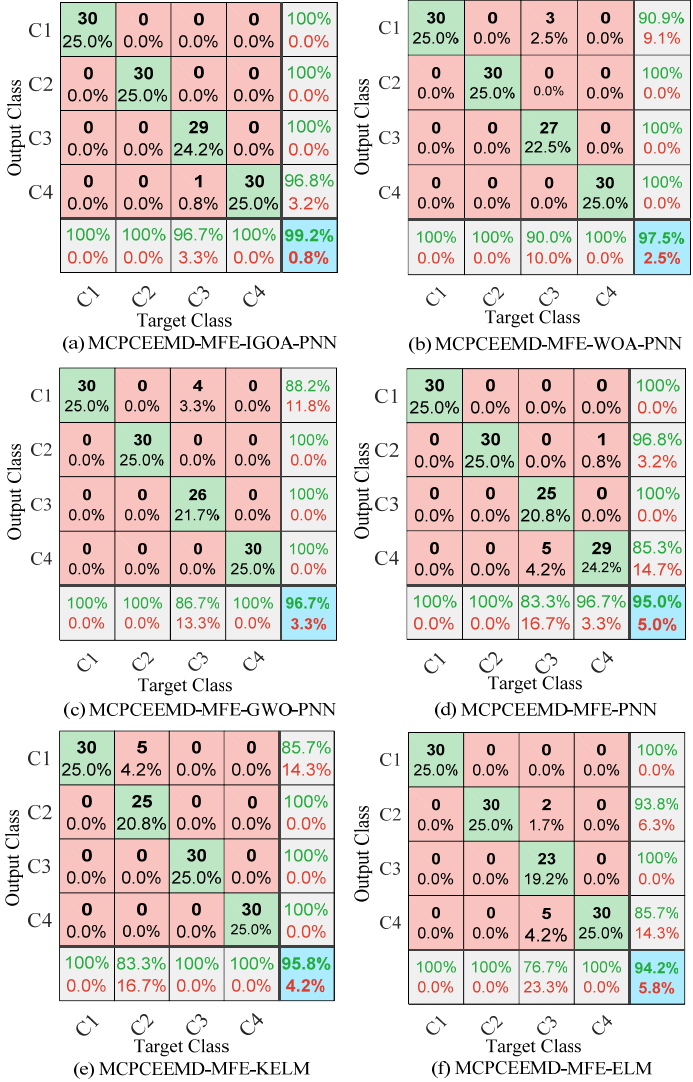
Figure 20. MFE curves of IMF4 and IMF5.